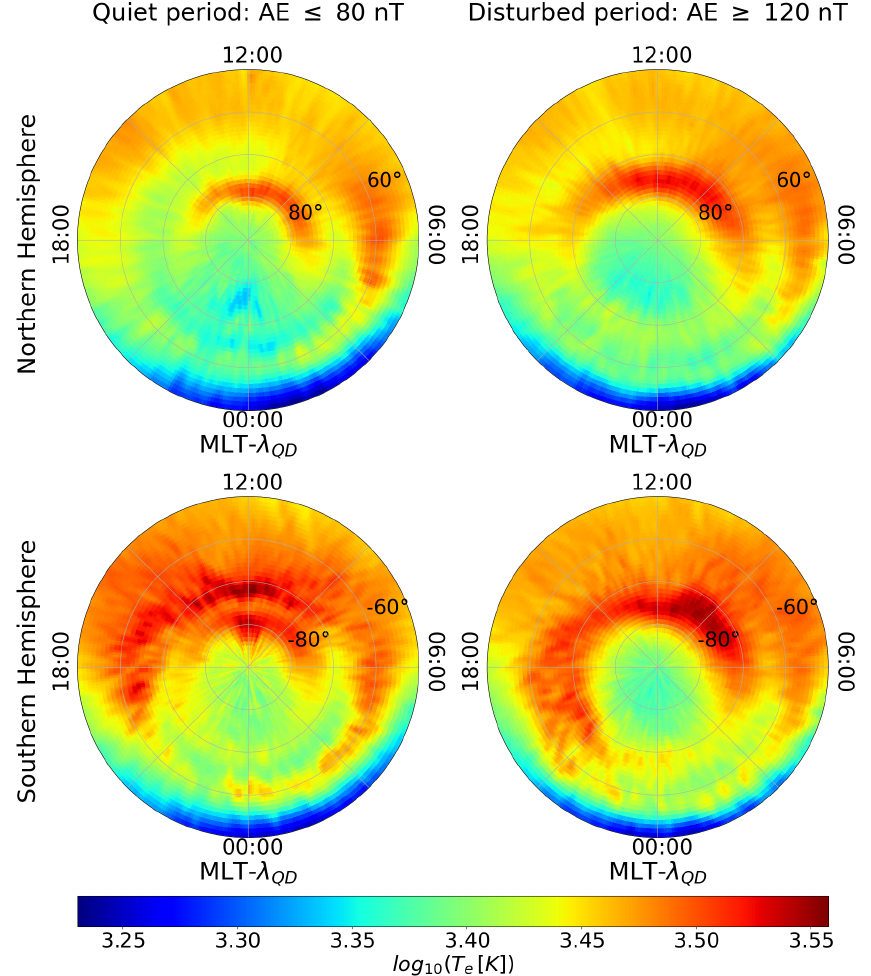
Figure 2. Polar view of the average spatial distribution of electron temperature ( T e ) for quiet ( left column) and disturbed ( right column) geomagnetic activity conditions, for the Northern and South- ern hemispheres, in QD-latitude ( λ QD > 50 ◦ and λ QD < − 50 ◦ for the Northern and Southern hemisphere, respectively) and MLT reference system. Maps are obtained using data recorded by Swarm A from 1 April 2014 to 28 February 2018. The concentric dashed circles represent contours of magnetic latitude separated by 10 ◦